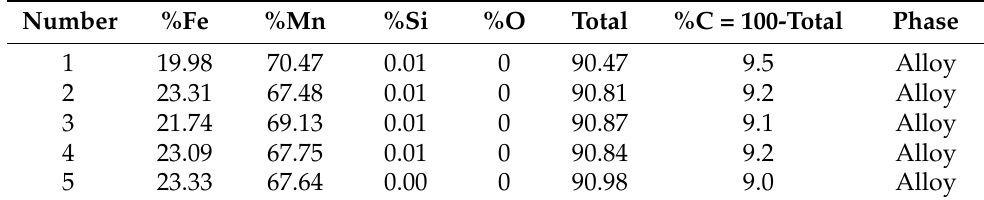
Figure 7. ( a ): Sample D BSE image: 1100 °C, 15% Fe addition; ( b ): Magnified s ample D analysis area BSE image: 1100 °C, 15% Fe addition; (grey = MnO, white = alloy).